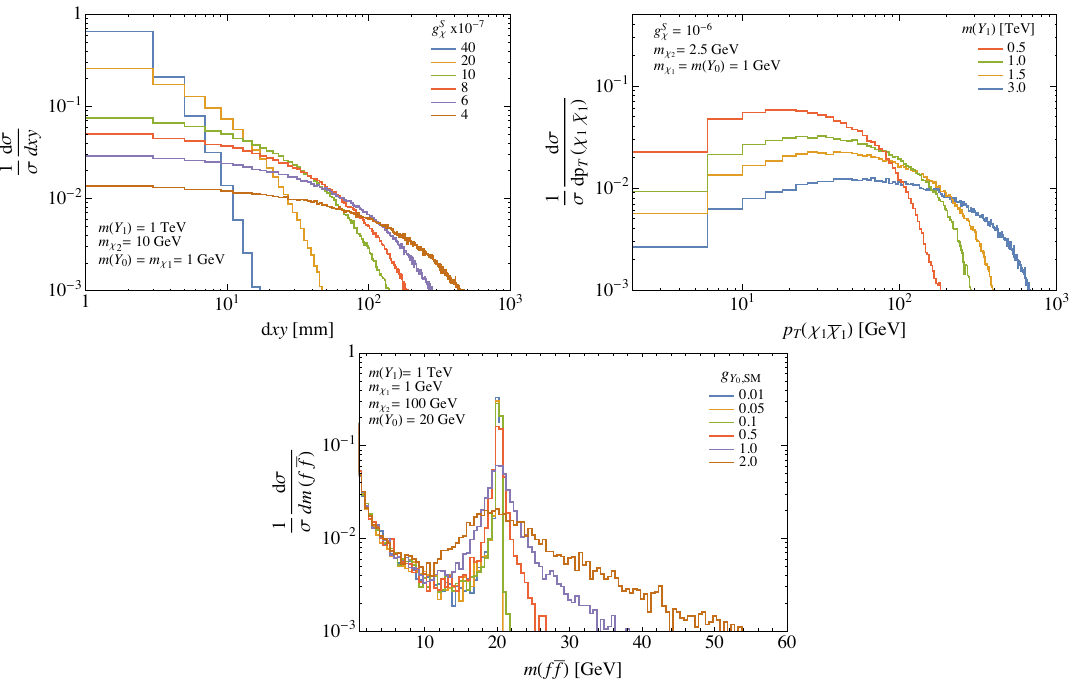
Figure 4 . Top left: the transverse impact parameter of Y S coupling values. Top right: the transverse momentum of the DM system ( p T ( (cid:31) 1 (cid:22) (cid:31) 1 )) for various Y V mediator masses. Bottom: the dimuon mass spectrum for several values of the Y S Other parameters in the DisplacedDM model are (cid:12)xed as per the panel headings. The distributions in all panels are